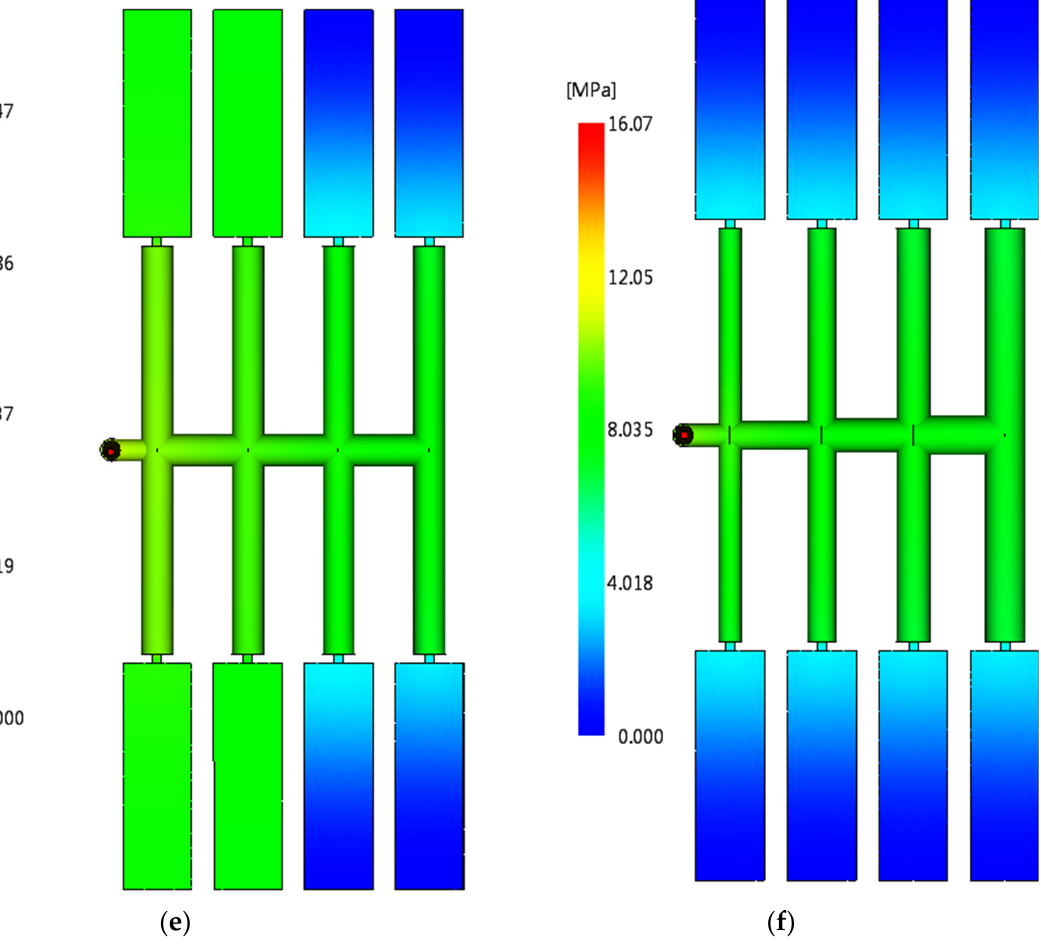
Figure 4. The comparison of an imbalanced and a balanced runner design of 16-cavity mold (a half model): ( a ) 75% melt fill of an imbalanced runner system, ( b ) 100% fill of an imbalanced runner system, ( c ) 75% fill of a balanced runner system, ( d ) 100% fill of a balanced runner system, ( e ) injection pressure of an imbalanced runner design, and ( f ) injection pressure of a balanced runner design.